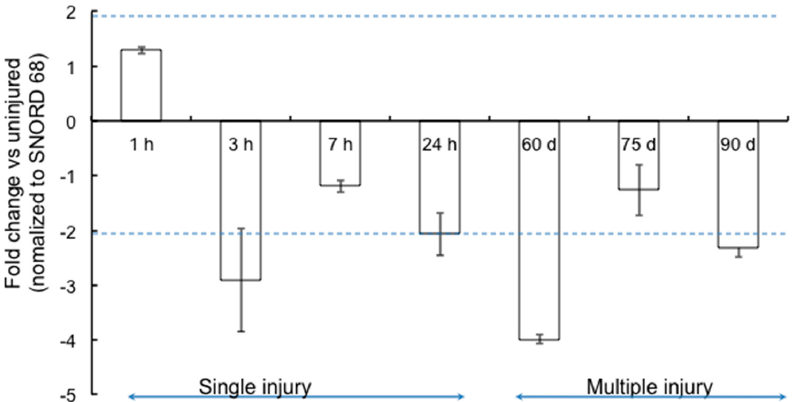
Figure 1. Expression profile of miR-15b in the joints following single (1, 3, 7 and 24 h) or multiple (4–6) bleeds (Days 60, 75 and 90). The levels of miR-15b were assessed in joint RNA by qPCR using predesigned locked nucleic acid (LNA) primers as described in the “Materials and Methods”. Small Nucleolar RNA, C/D Box 68 (SNORD68) levels were used as the housekeeping control for normalization. Data is representative of mean ± SD of three replicates. p < 0.05 is considered to be statistically significant.